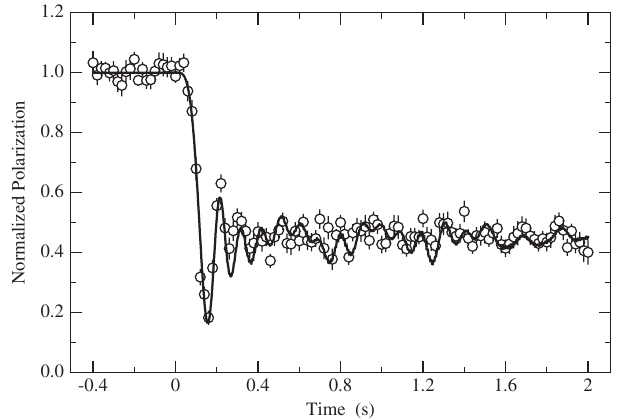
FIG. 21. Measurements off resonance with an uncooled beam. The model calculation was adjusted to reproduce this data by changing the distribution of synchrotron amplitudes.